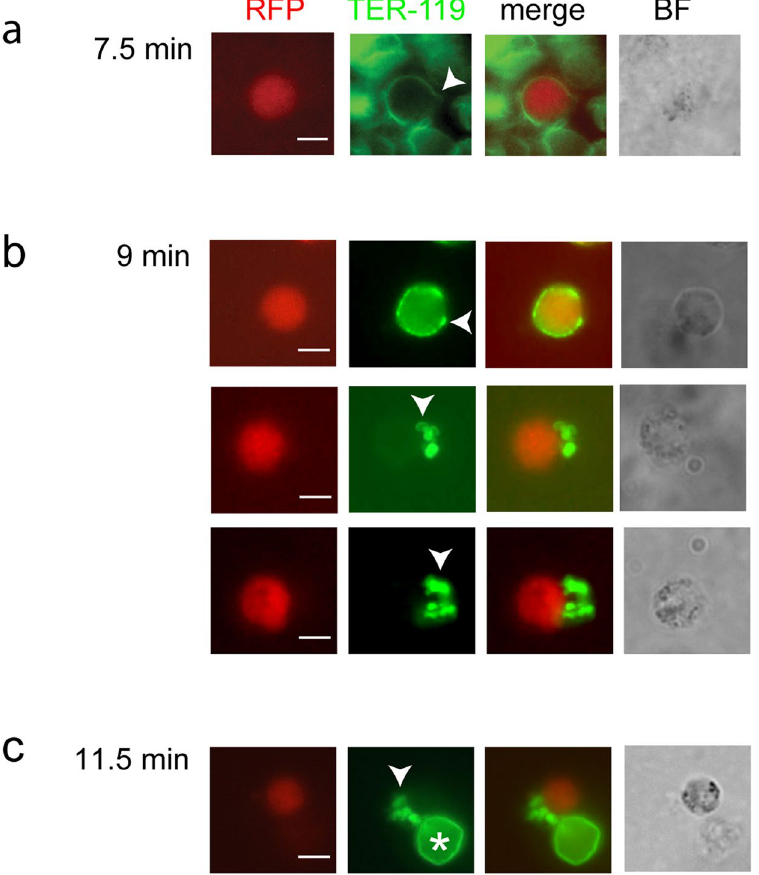
Figure 4. Outside-out vesiculation revealed with TER-119 label. ( a – c ) Females (expressing RFP, red) were fixed at different time points after activation and the RBCM labeled with TER-119 (green). ( a ) 7.5 min after activation the RBCM has opened at a single site. ( b ) Three females having completed gametogenesis 9 min after activation. Labeled outside-out vesicles remain in proximity to the gametes. ( c ) Completed gametogenesis at 11.5 min. Labeled vesicles remain close to the gamete. An intact RBC is indicated with an asterisk. White arrows point to opened or vesiculated RBCM. Scale bar, 5 µ